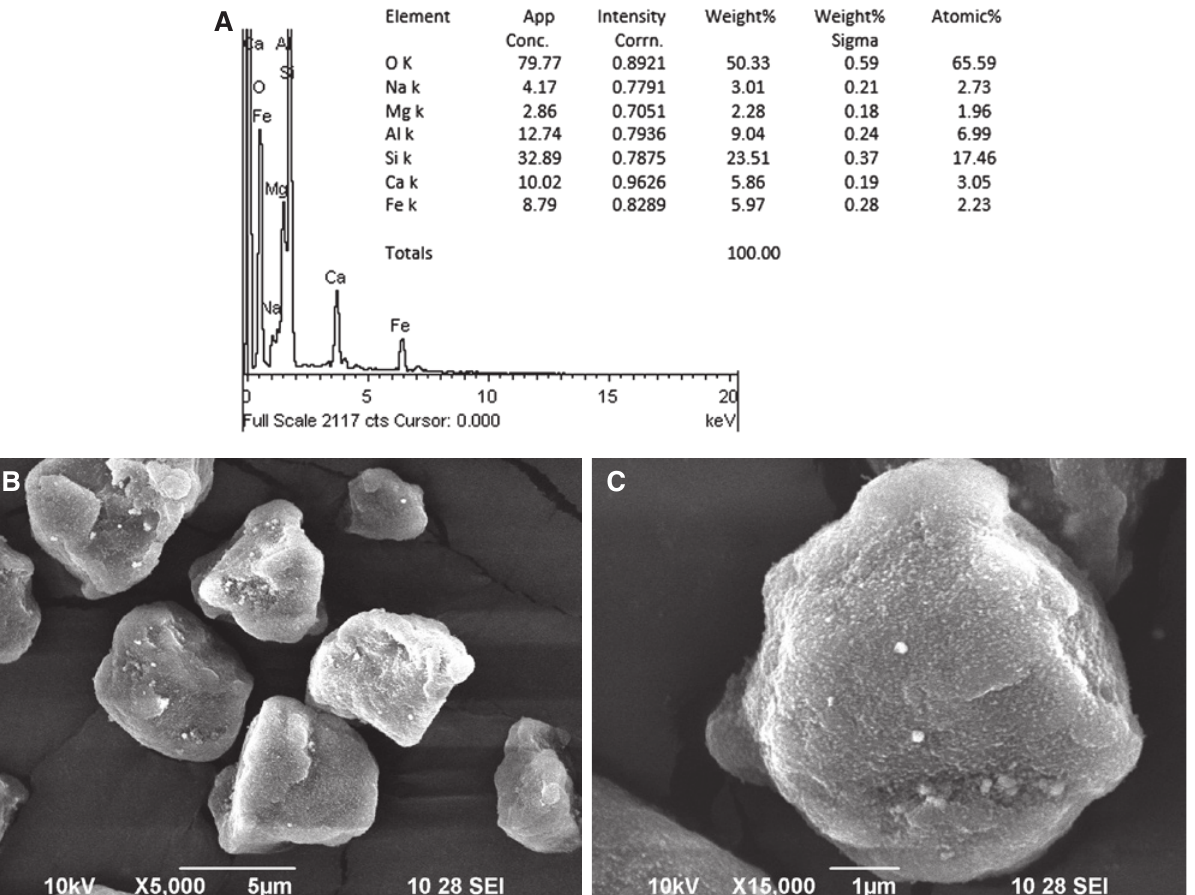
Figure 2: (A) EDAX test report of WSD particles, (B) SEM of the WSD particle and (C) specific surface area of the WSD particle.